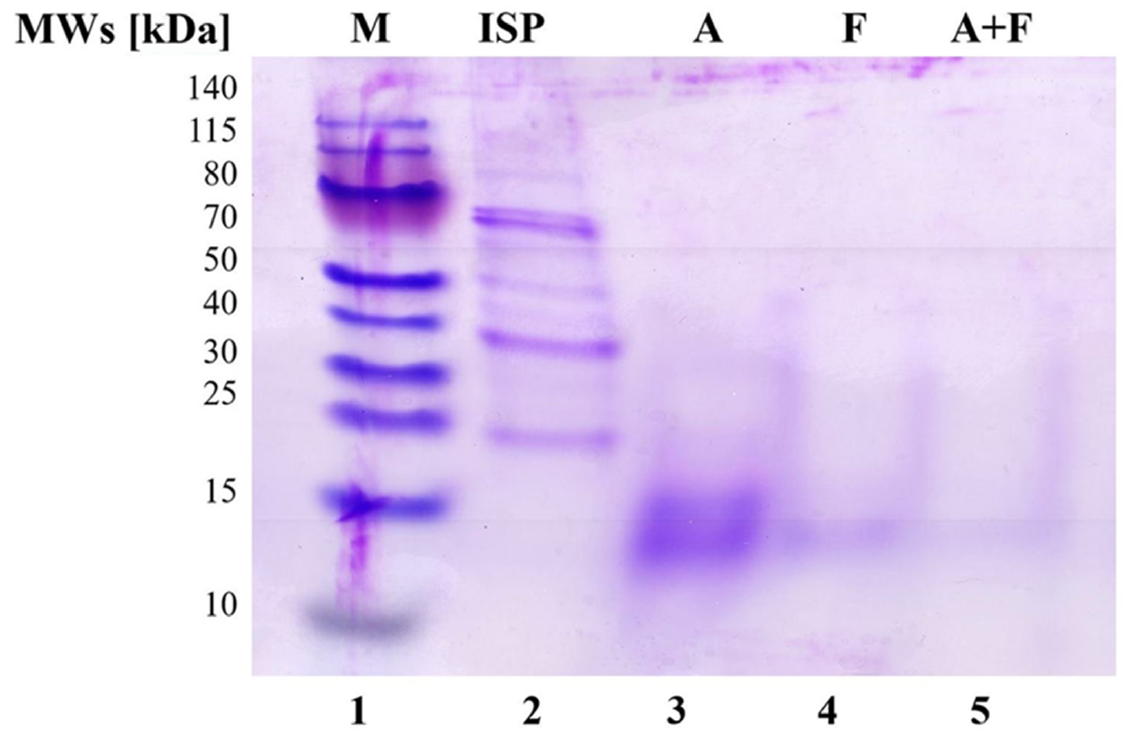
Figure 1. SDS-PAGE analysis of protein MWs by 12% precast Bis-Tris Invitrogen ® : Thermo Scientific TM PageRuler TM . Lanes: prestained protein ladder (M, lane 1); soy protein isolate (SPI, lane 2); SPH obtained from the reaction with Alcalase ® (A, lane 3), Flavourzyme ® (F, lane 4) and Alcalase ® + Flavourzyme ® (A + F, lane 5).